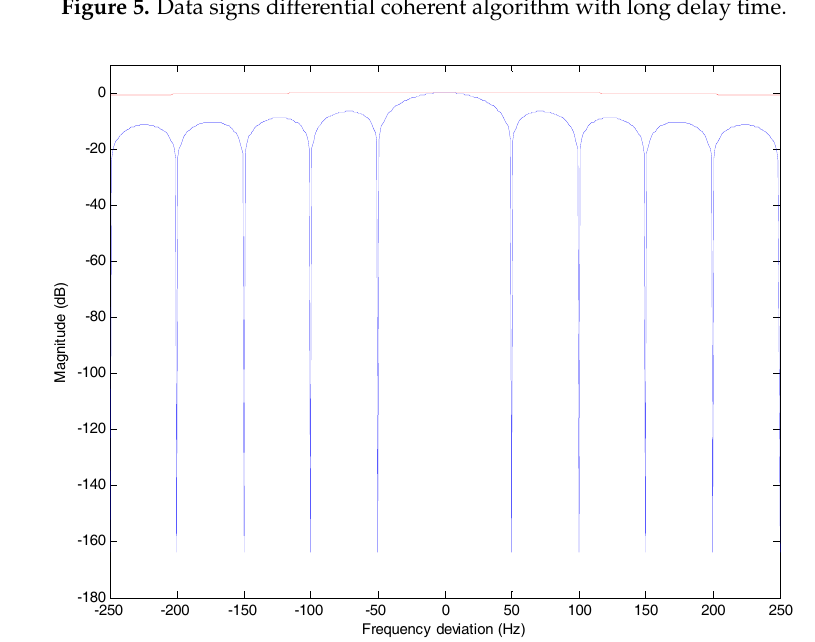
Figure 6. The amplitude attenuations of ML and DCML bit synchronization algorithms due to frequency deviation. The blue line is for ML and the red line is for DCML.